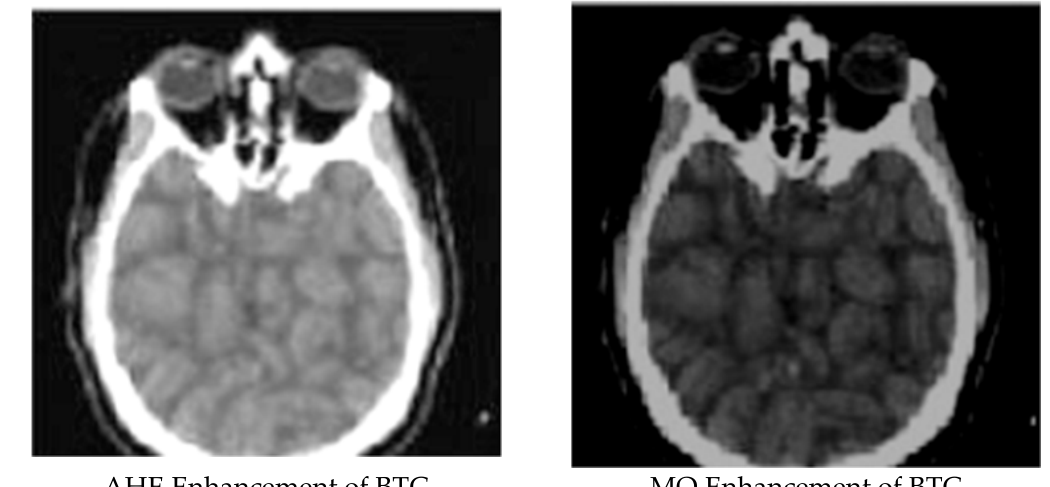
Figure 4. Lossless techniques: Enhancement of BTC using AHE and MO.